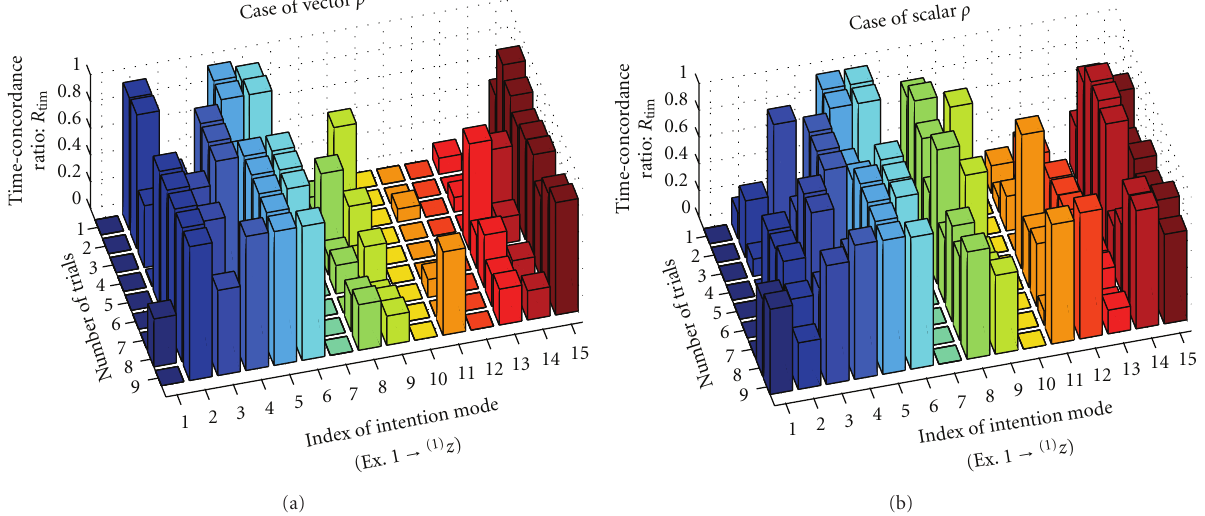
Figure 13: Comparison of time-concordance ratios R tim in two cases: results using vector ρ (a) and scalar ρ (b).